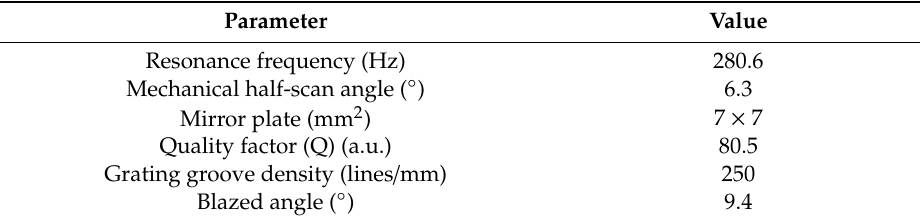
Table 1. Parameters of the FR4-based electromagnetic scanning micrograting.